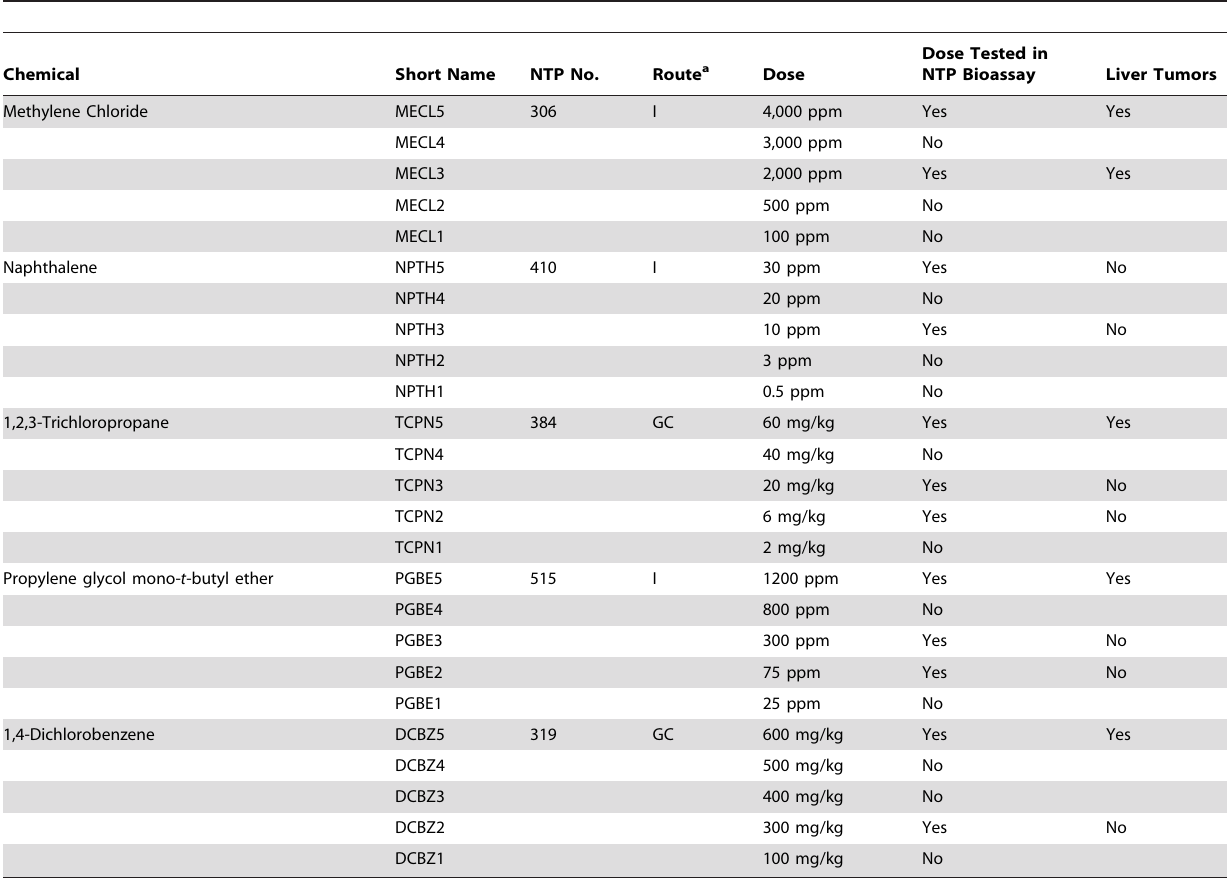
Table 2. Dose response treatment groups and abbreviations used in the 90 day exposure with the results from the NTP rodent cancer